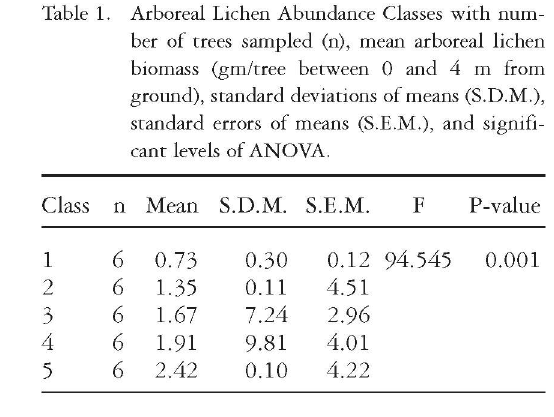
Table 1. Arboreal Lichen Abundance Classes with num¬ ber of trees sampled (n), mean arboreal lichen biomass (gm/tree between 0 and 4 m from ground), standard deviations of means (S.D.M.), standard errors of means (S.E.M.), and signifi¬ cant levels of